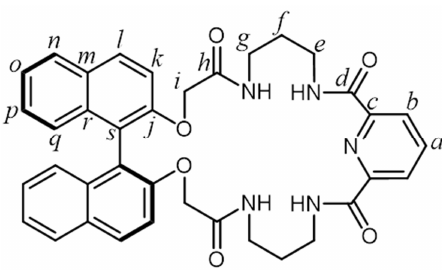
Figure 6. The structure of the receptor 2 with the designations of hydrogen and carbon